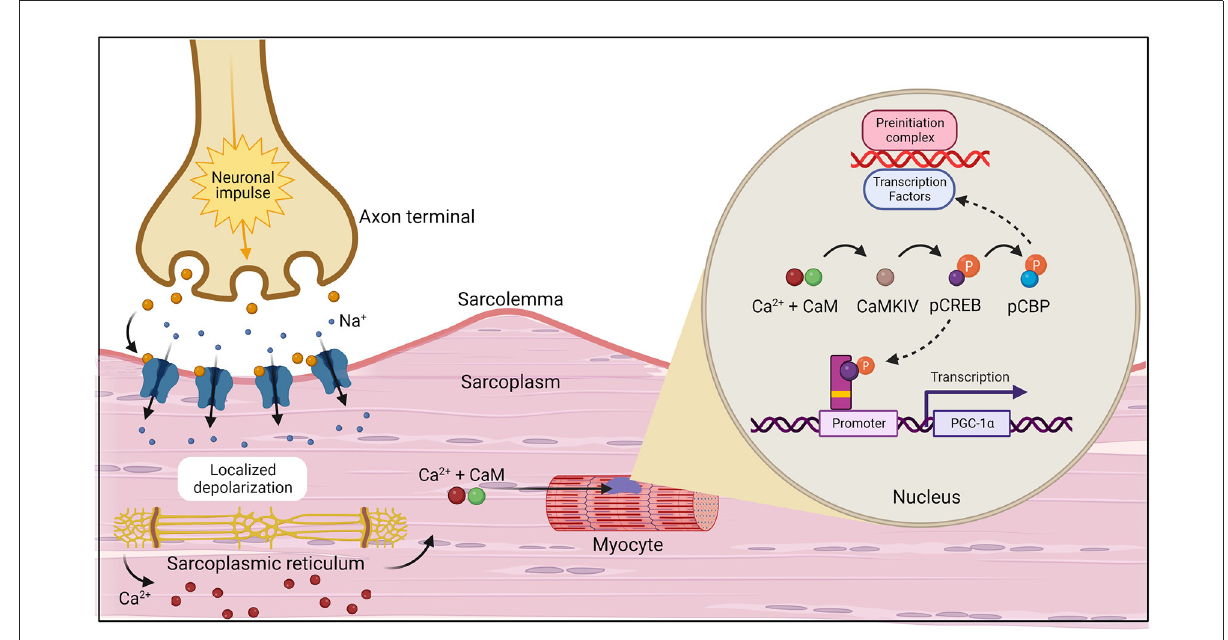
FIGURE3 The initiation of muscle contraction followed by the two primary pathways, calcium (Ca 2 + ) calmodulin-dependent protein kinase IV (CaMKIV)/calcineurin A (CnA) and cAMP response element-binding protein (CREB) that activate the PGC-1 α gene which act to increase mitochondrial biogenesis (20). Created with